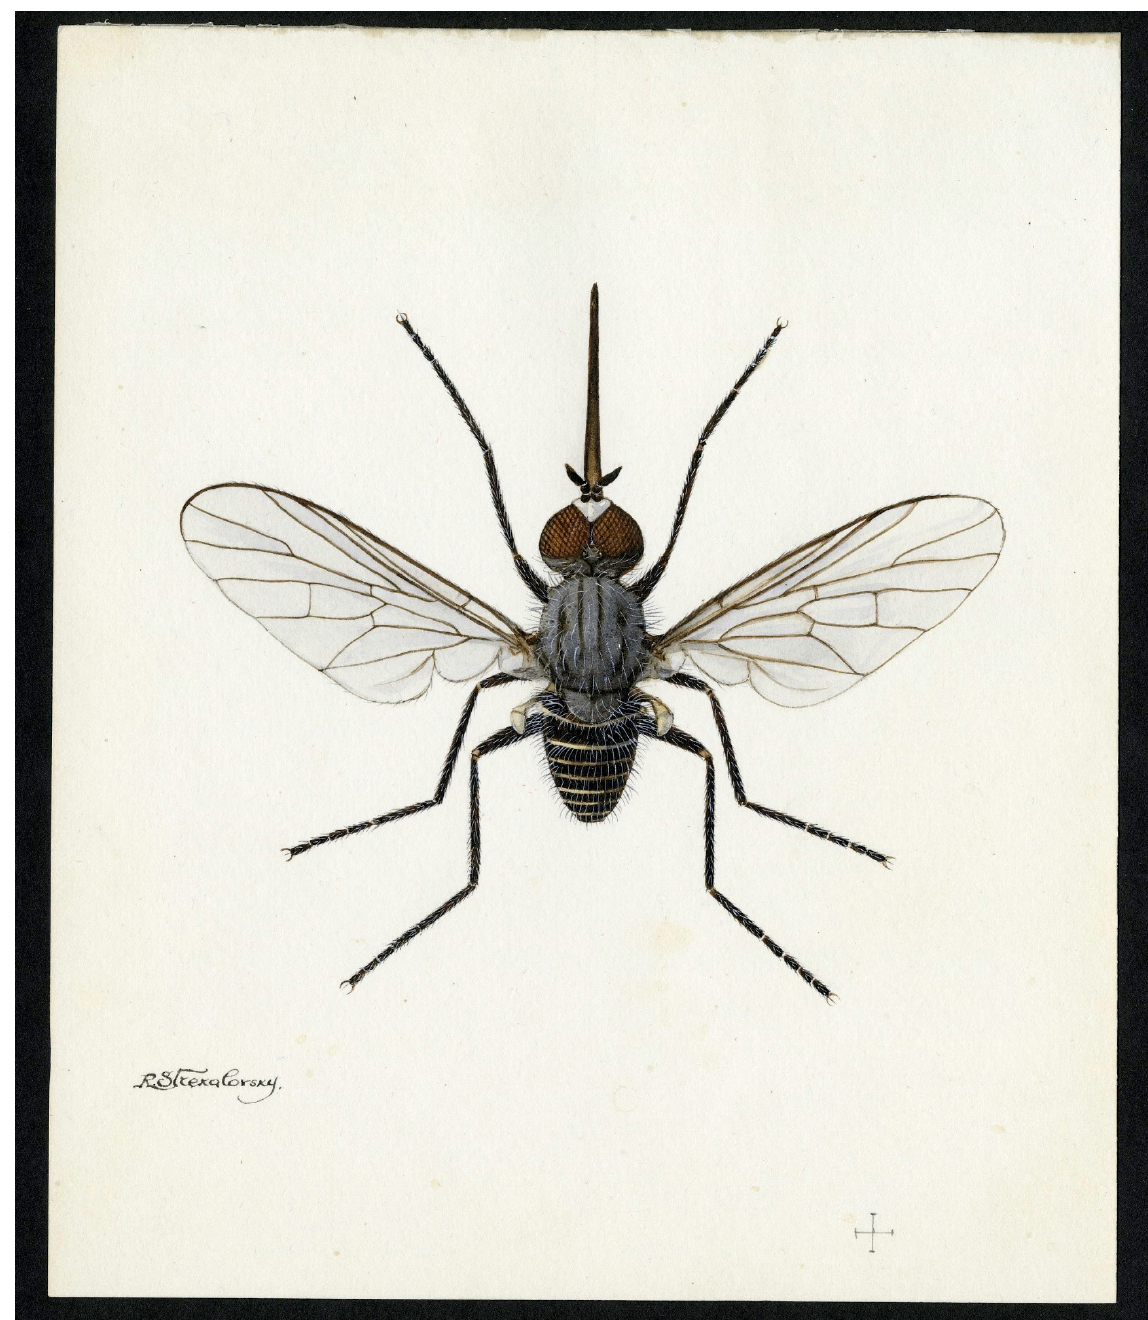
Fig. 68. Usia grisea Efflatoun, 1945, habitus, Smithsonian Institution Archives. Image